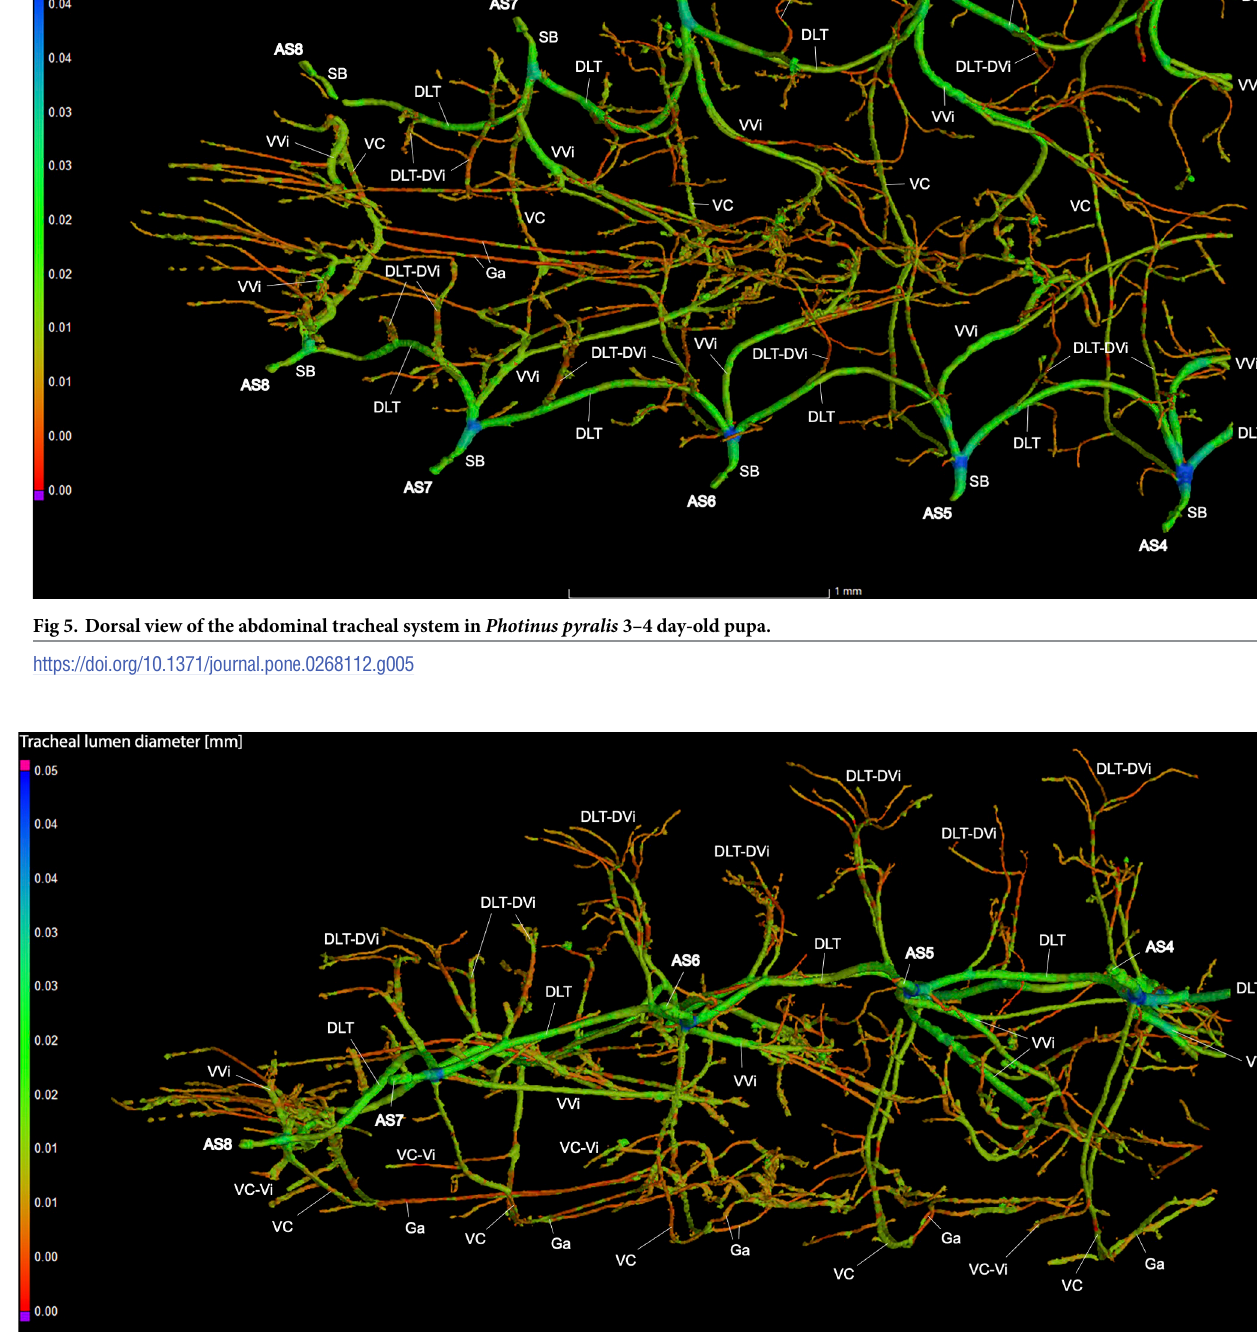
PLOS ONE | https://doi.org/10.1371/journal.pone.0268112 June 1,